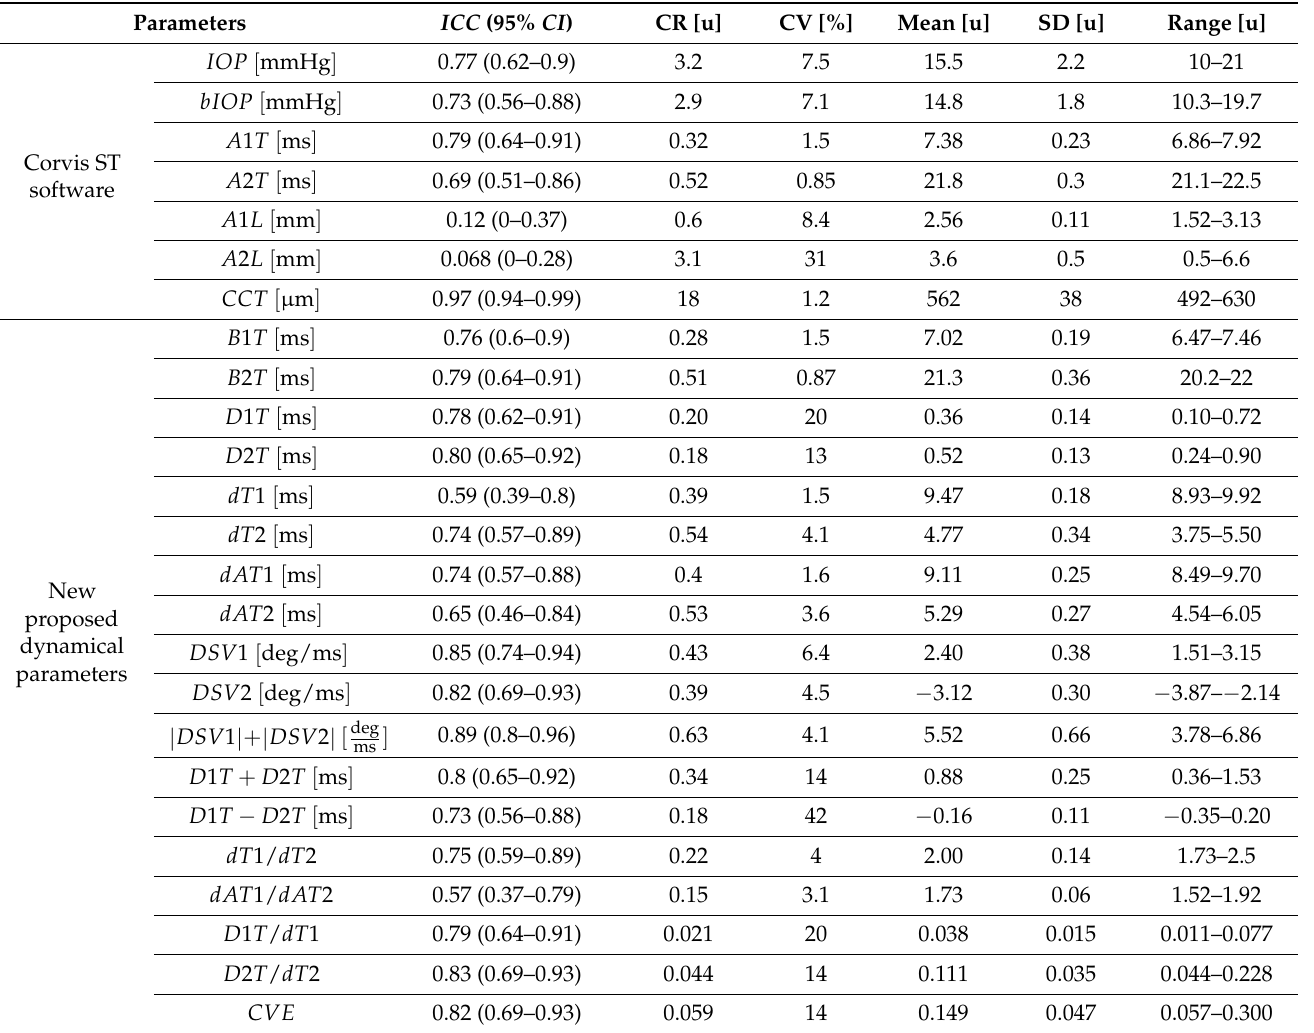
Table 1. The mean values of the considered parameters, their standard deviations (SD), ranges, as well as measures of their repeatability in the form of coefficient of repeatability (CR), coefficient of variation (CV), and intraclass correlation coefficient (ICC) with 95% confidence interval (CI); u—the unit of a given